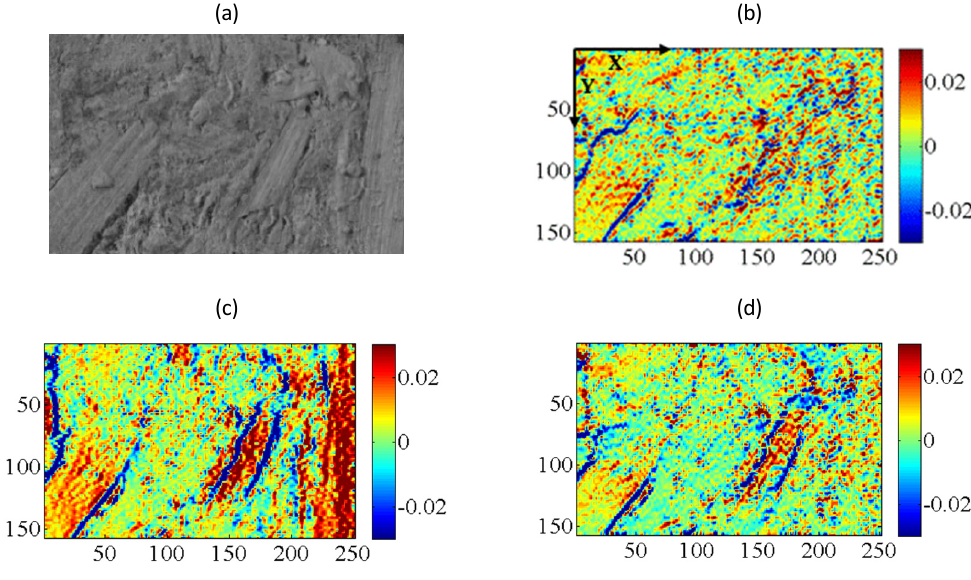
Figure 4. (a) dry state, and strains equivalent to 76% RH (b) (cid:2013) (cid:3051)(cid:3051) (c) (cid:2013) (cid:3052)(cid:3052) and (d) (cid:2013) (cid:3051)(cid:3052) .